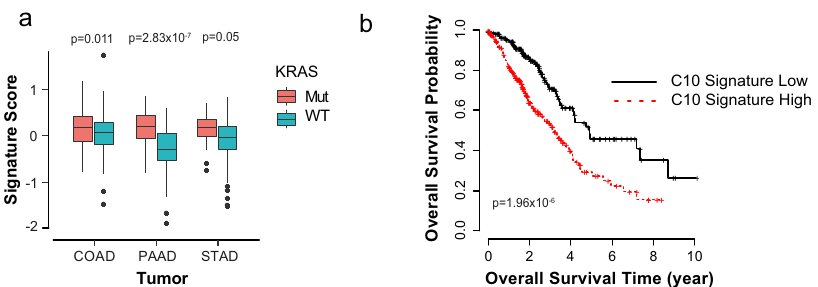
Fig. 5 C10-speci fi c signature is conserved in multiple tissue ADCs and it is associated with lower overall survival. a Boxplots for distributions of the signature scores for combining the positive and negative signature genes over KRAS -mutant samples versus WT samples cross four adenocarcinomas (colon, COAD, N = 100 mutant KRAS and N = 211 WT; pancreas, PAAD, N = 127 mutant KRAS and N = 31 WT; stomach, STAD, N = 18 mutant KRAS and N = 294 WT). P values are indicated. b Survival analysis between C10 signature high and low groups ( p value = 1.96 × 10 − 6 , hazard ratio = 2.37). C10 low group: n = 223, and C10 high group: n